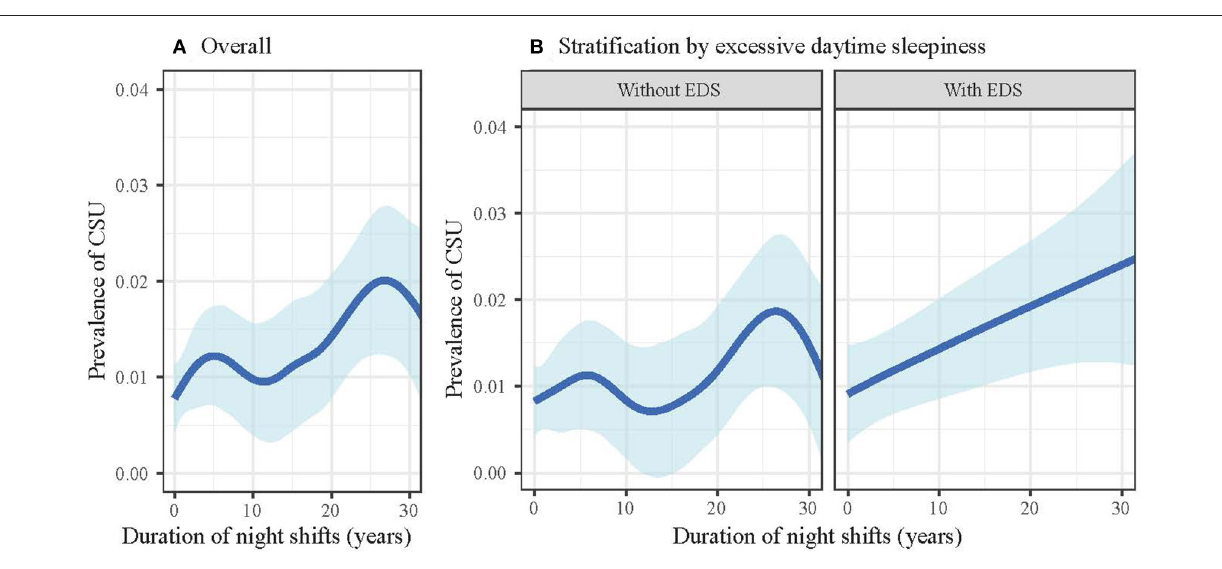
FIGURE 3 | Duration of night shift work and the prevalence of chronic spontaneous urticaria, stratified by excessive daytime sleepiness. The blue curve signifies the estimated prevalence of urticaria, and the light blue band signifies the 95% confidence interval. (A) All participants; (B) stratification analysis by EDS. CSU, chronic spontaneous urticaria; EDS, excessive daytime